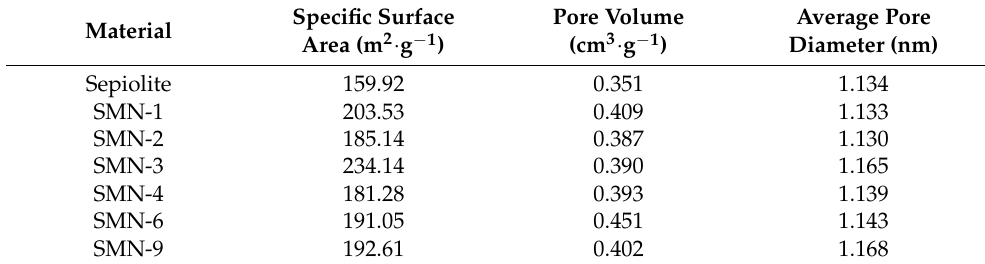
Table 1. Textural properties of as-prepared composites.